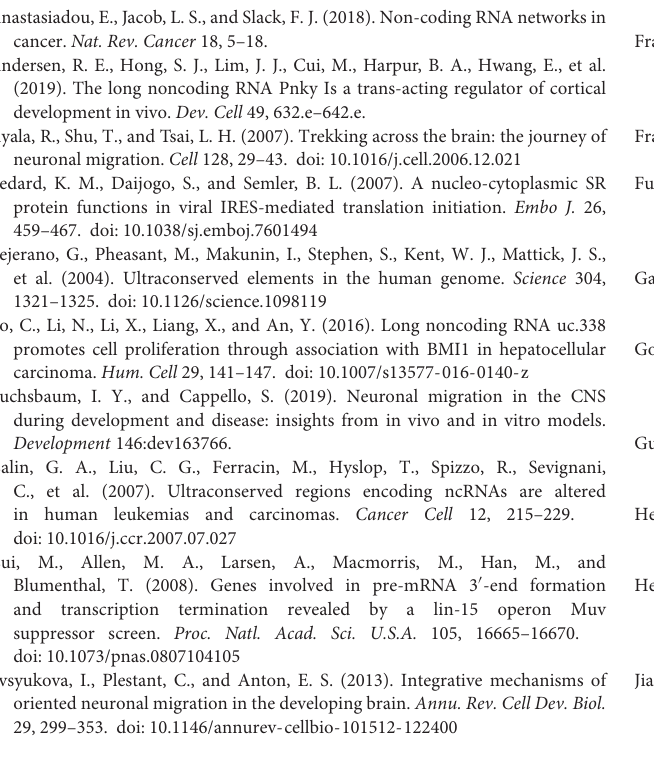
Supplementary Figure 1 | Cloning of the full-length mouse lncRNA T-uc.189 gene. (A) Sequencing the PCR products from the 5 (cid:48) - and 3 (cid:48) -RACE assays revealed the boundary between the universal anchor primer and the T-uc.189 sequences. (B) Nucleotide sequence of the full-length mouse lncRNA T-uc.189 gene. Supplementary Figure 2 | Nucleotide and amino acid sequences of the ORF prediction alignment of T-uc.189. (A) Alignment of the T-uc.189 full-length sequence with the ten transcripts of Srsf3 . (B) The predicted amino acid sequences of T-uc.189 and Srsf3 -204 (non-coding RNA) aligned with Srsf3 -202 (protein-coding gene). Supplementary Figure 3 | T-uc.189 was detected by RT-PCR and Sanger sequencing. (A) Total RNA was harvested from the E14.5 mouse brain and